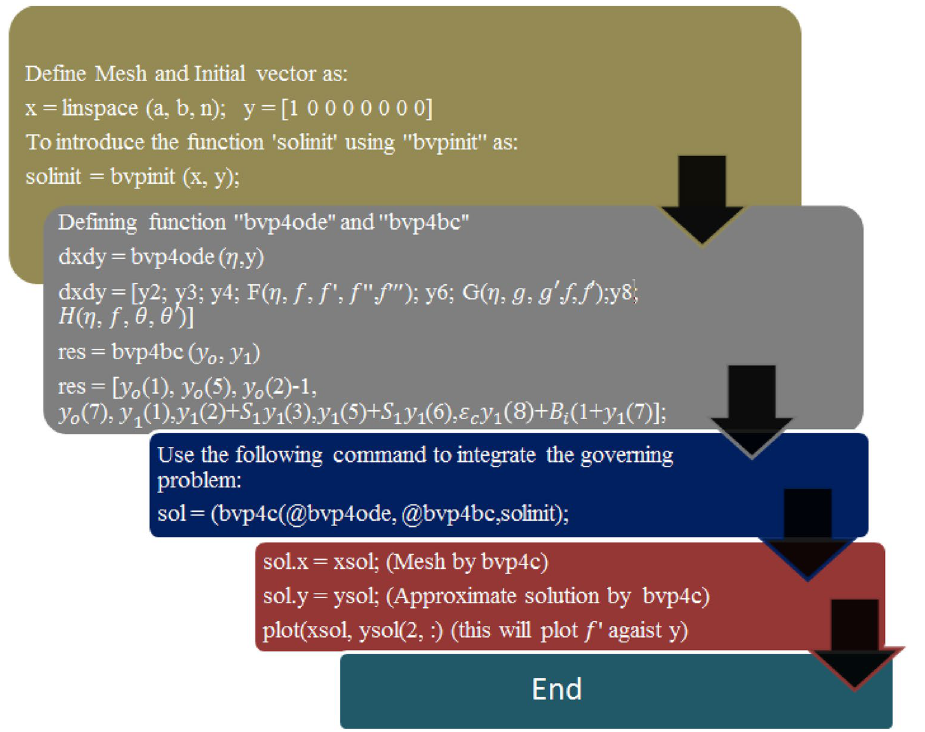
Figure 2. Flow chart of the